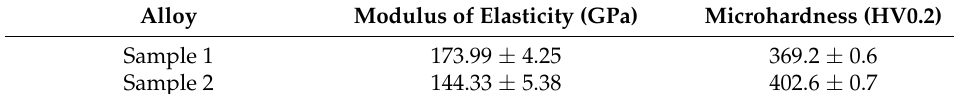
Figure 3. Three-point flexural test diagrams: ( a ) Sample 1 and ( b ) Sample 2. Table 4. Modulus of elasticity and hardness values for Sample 1 and Sample 2. Alloy